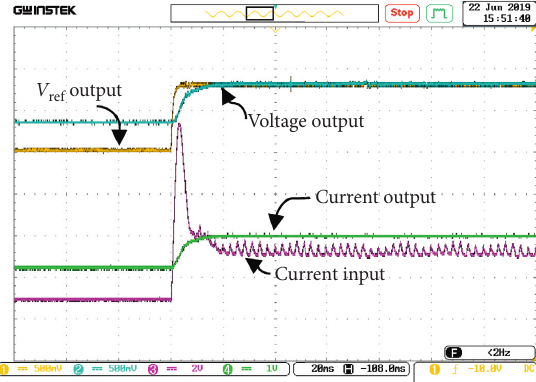
Figure 16: Result of the four-phase interleaved boost converter circuit at voltage of 24V without the controller.